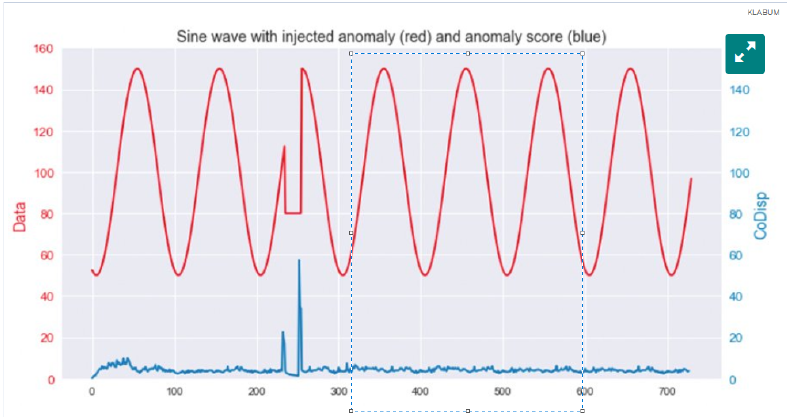
Figure 1. “ When time is of the essence” [6] waveform sampling study of truncated data. Figure 1. “When time is of the essence” [6] waveform sampling study of truncated